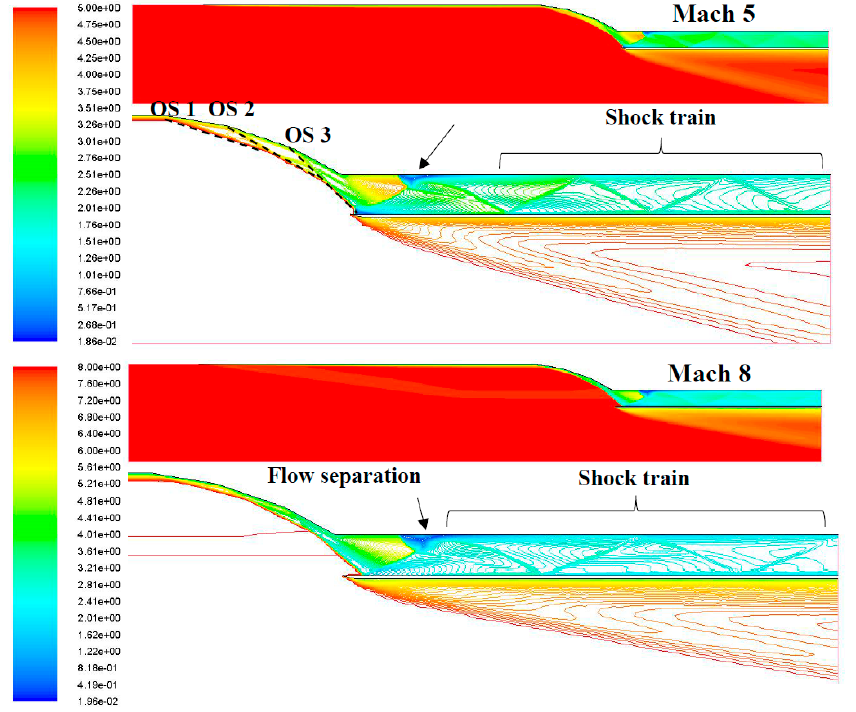
Figure 15. Mach contour of the three ramp inlet at Mach 5 and 8.